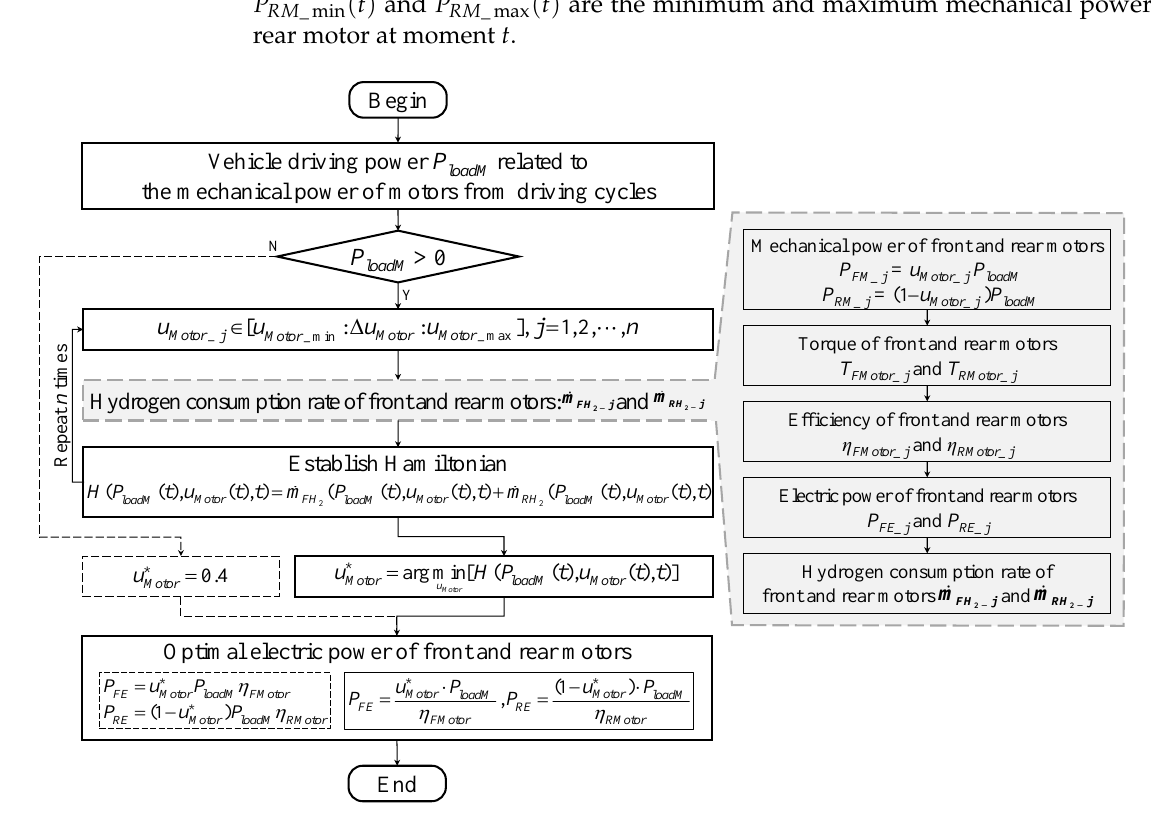
Figure 6. Power distribution between the front and rear